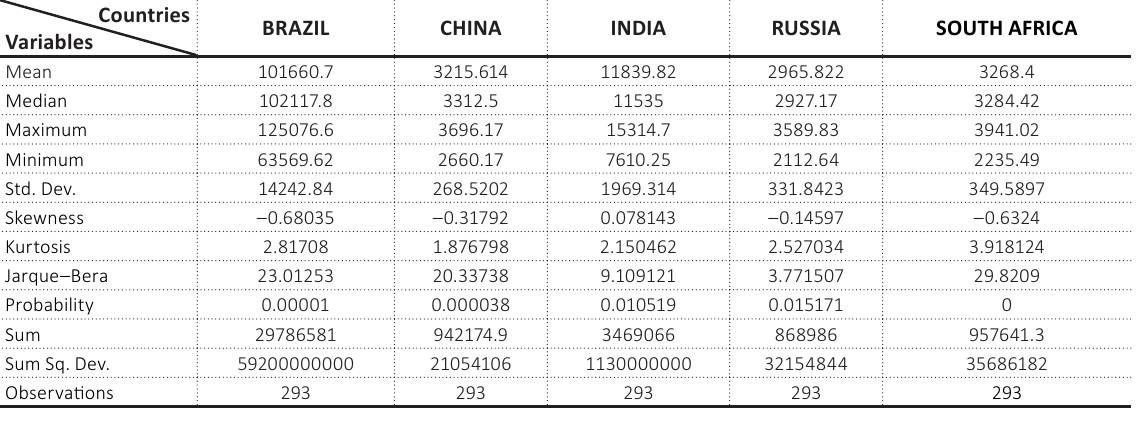
Table 2. Descriptive statistics during the pandemic period